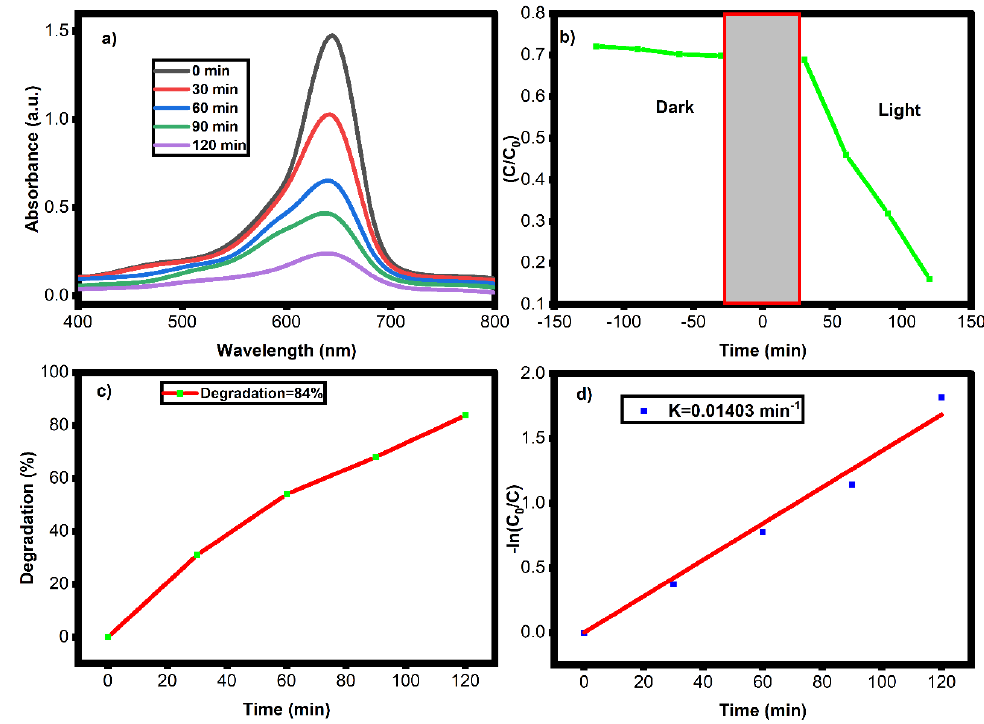
Figure 8. ( a ) Photocatalytic degradation, ( b ) light kinetics, ( c ) degradation percentage, and ( d ) pseudo-order kinetic spectrum of biosynthesized CoFe 2 O 4 nanoparticles.